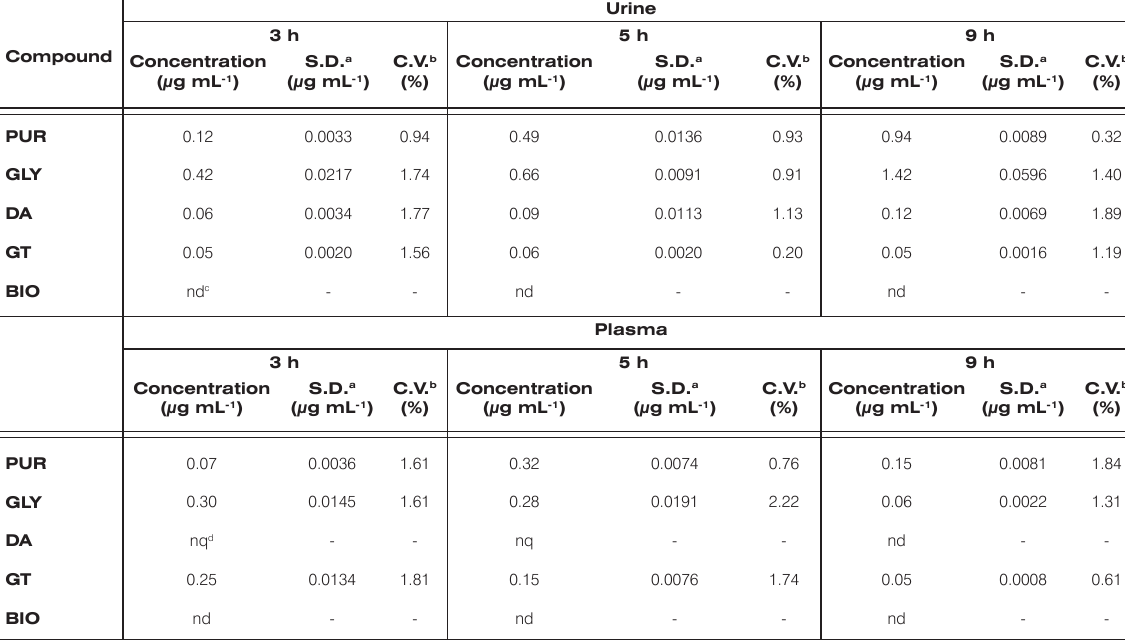
a. Standard deviation of the concentrations measured. b. Coefficient of variation of the concentrations measured. c. Not detected. d. Not